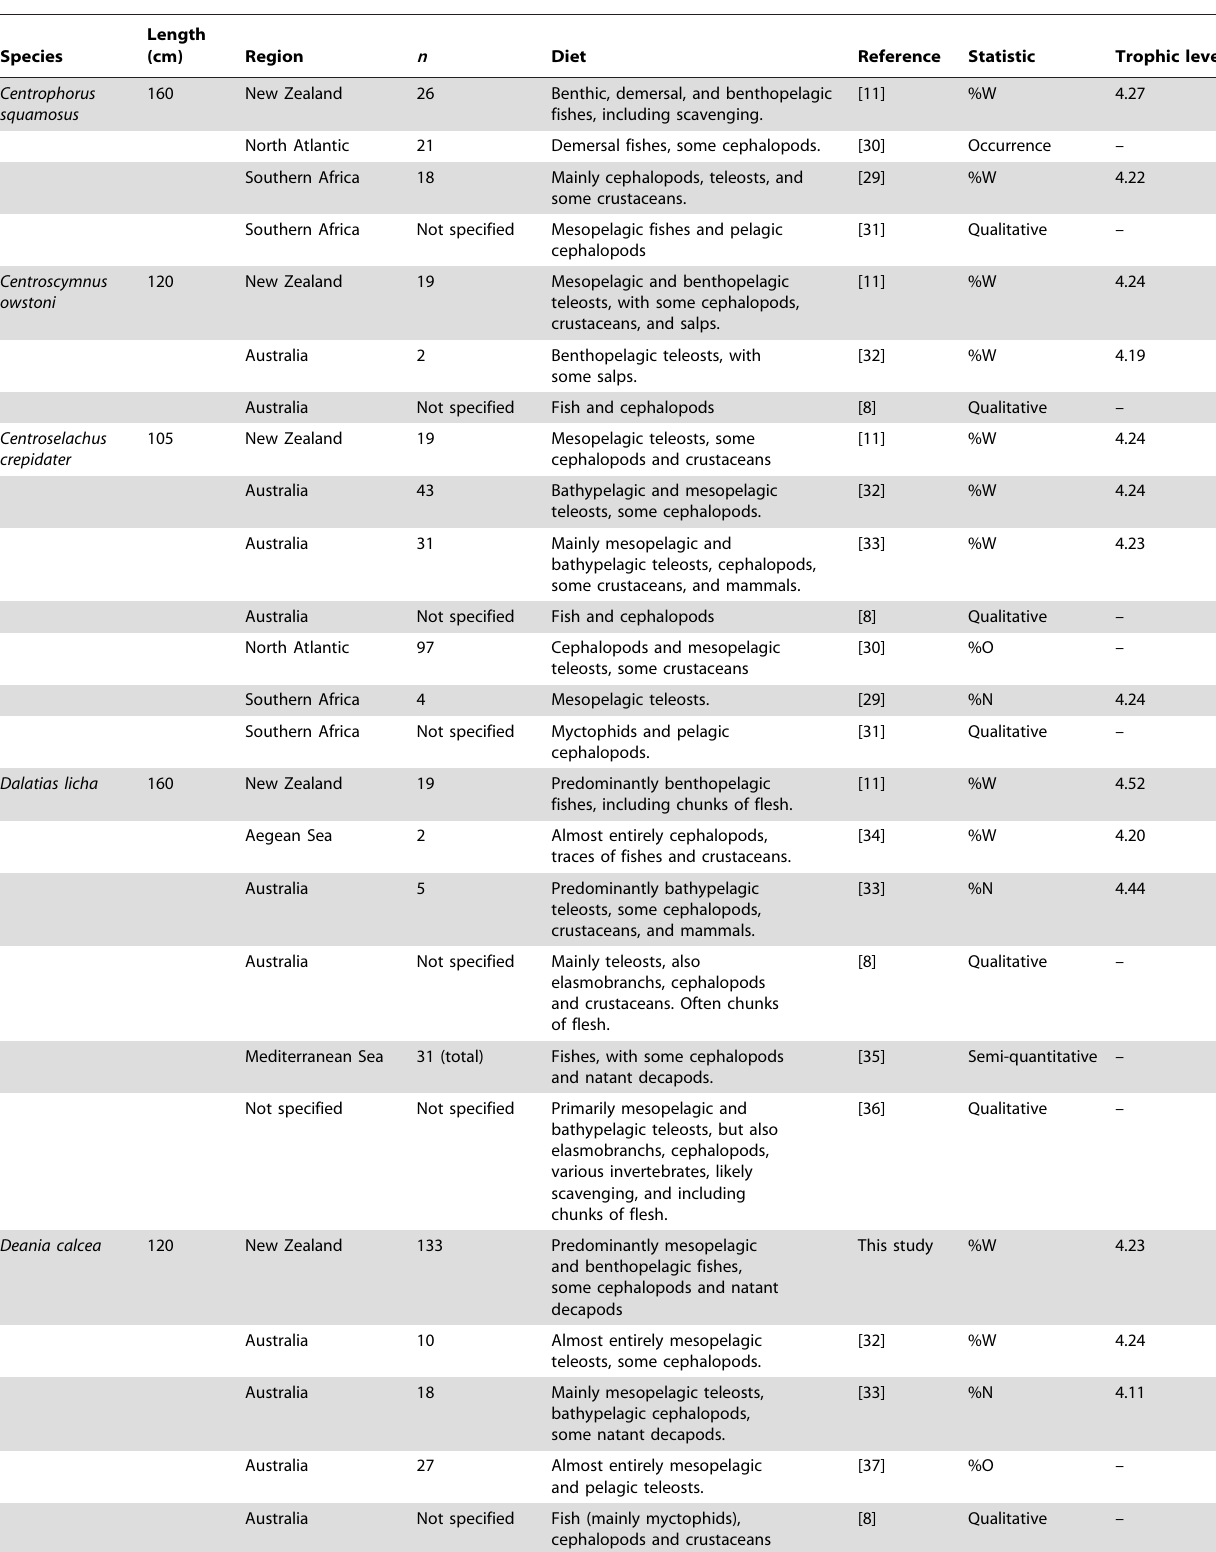
Table 6. Summary of Squaliforme shark diet studies for species commonly caught during Chatham Rise bottom trawl surveys.